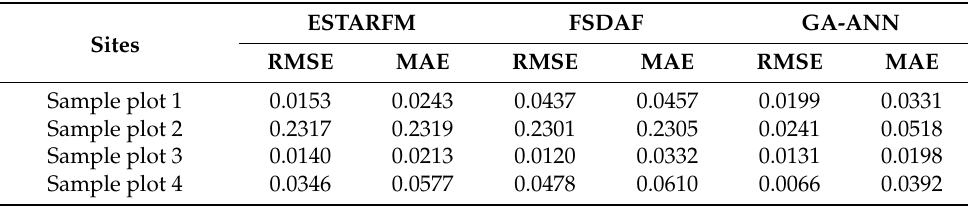
Table 5. Comparison table of RMSE and MAE for each method with original Landsat NDVI.